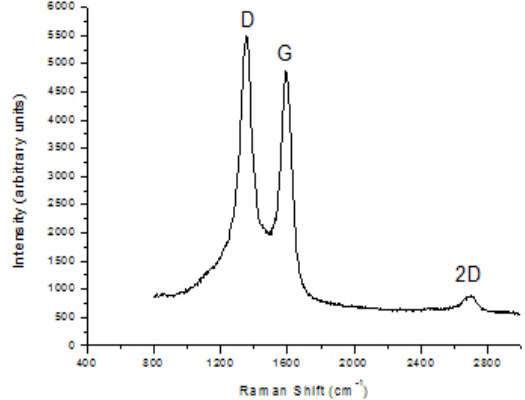
Fig. 3 - X-Ray diffraction pattern of the sample that underwent heat treatment in vacuum, at 850°C for 10 minutes. Fig. 4 – Raman spectrum of the carbon thin